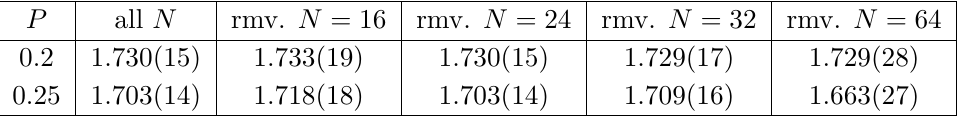
Table 6. Values of c for W con + W mix with data for different N removed. Without n t = 16 .